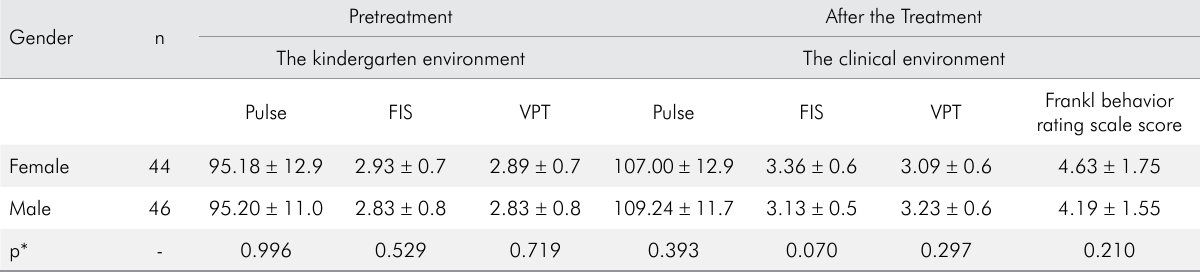
Table 1. The pulse rates, facial images scale (FIS) scores, Venham picture test (VPT) scores scores, and Frankl behavior rating scale scores according to gender at the kindergarten before treatment and at the dental clinic after treatment. Pretreatment Gender n